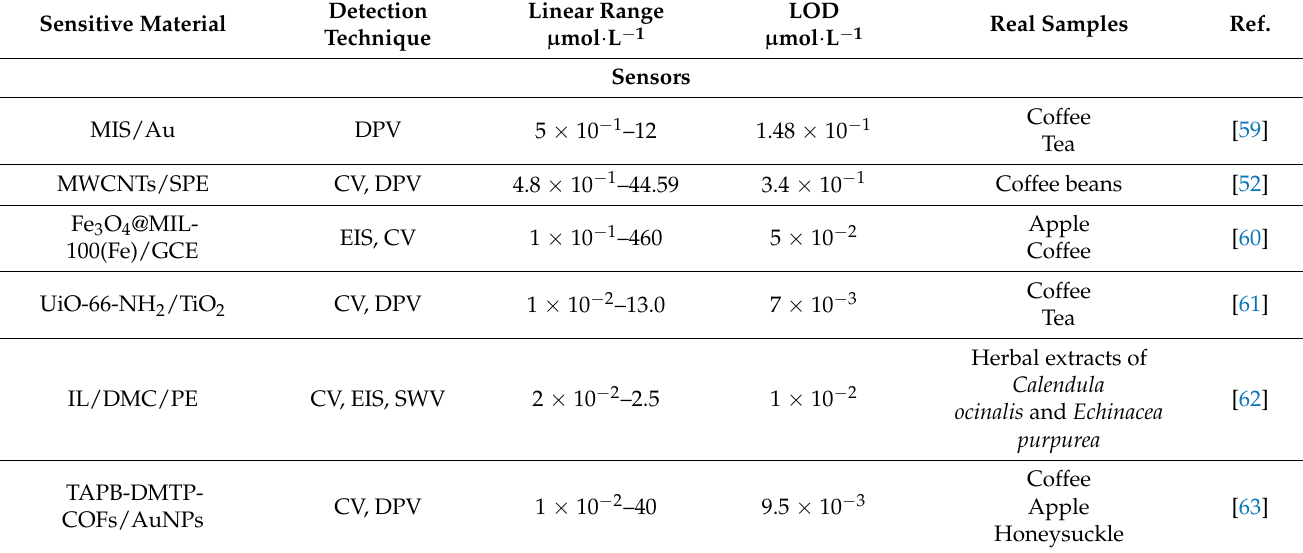
Table 3. Main electrochemical sensors and biosensors used for CGA detection. Sensitive